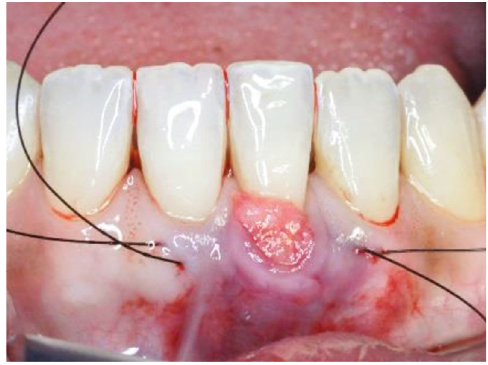
Figure 11: Removal of the coronal traction